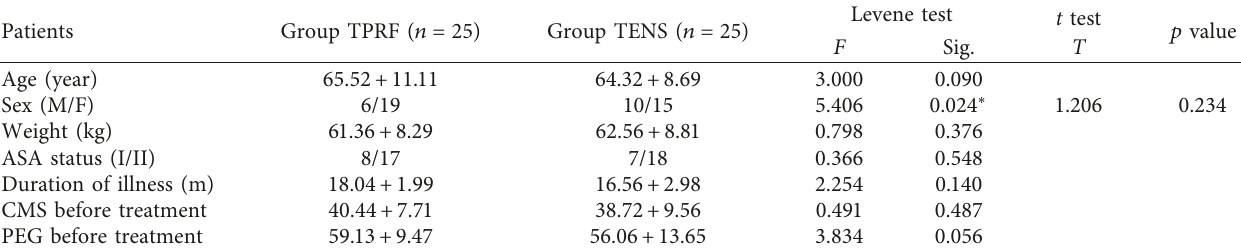
Table 1: Demographic data, ASA status, duration of illness, and CMS/PEG before treatment. Patients